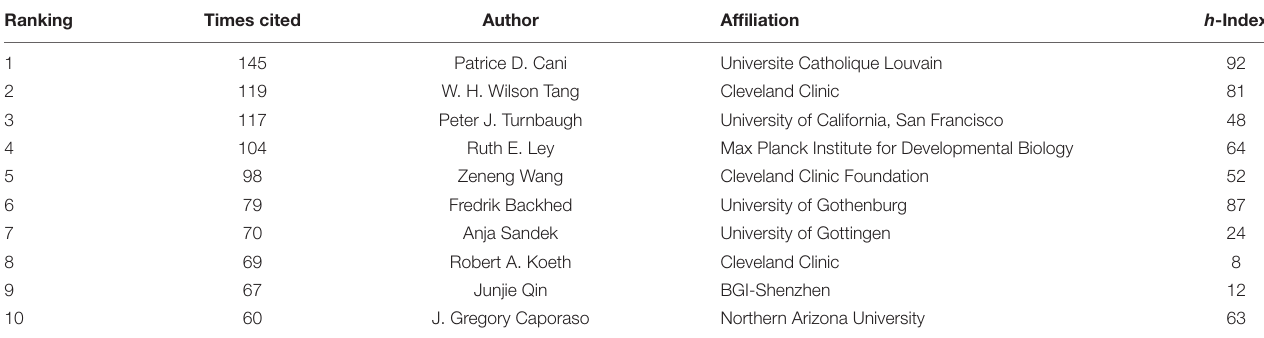
TABLE 3 | Ranking of the top 10 co-cited authors with the most citations. Ranking Times